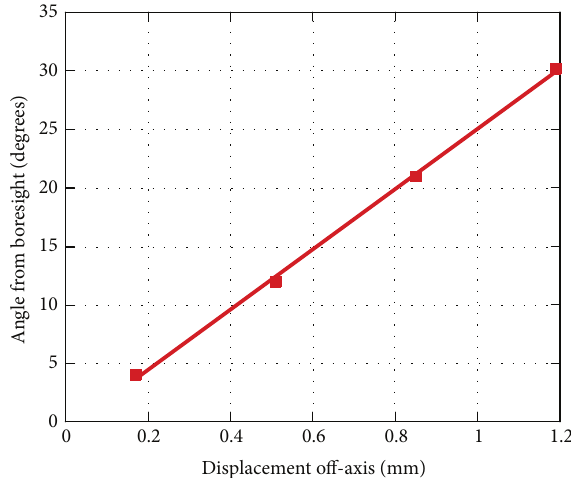
Figure 18: Far-field pattern of detector 350GHz.